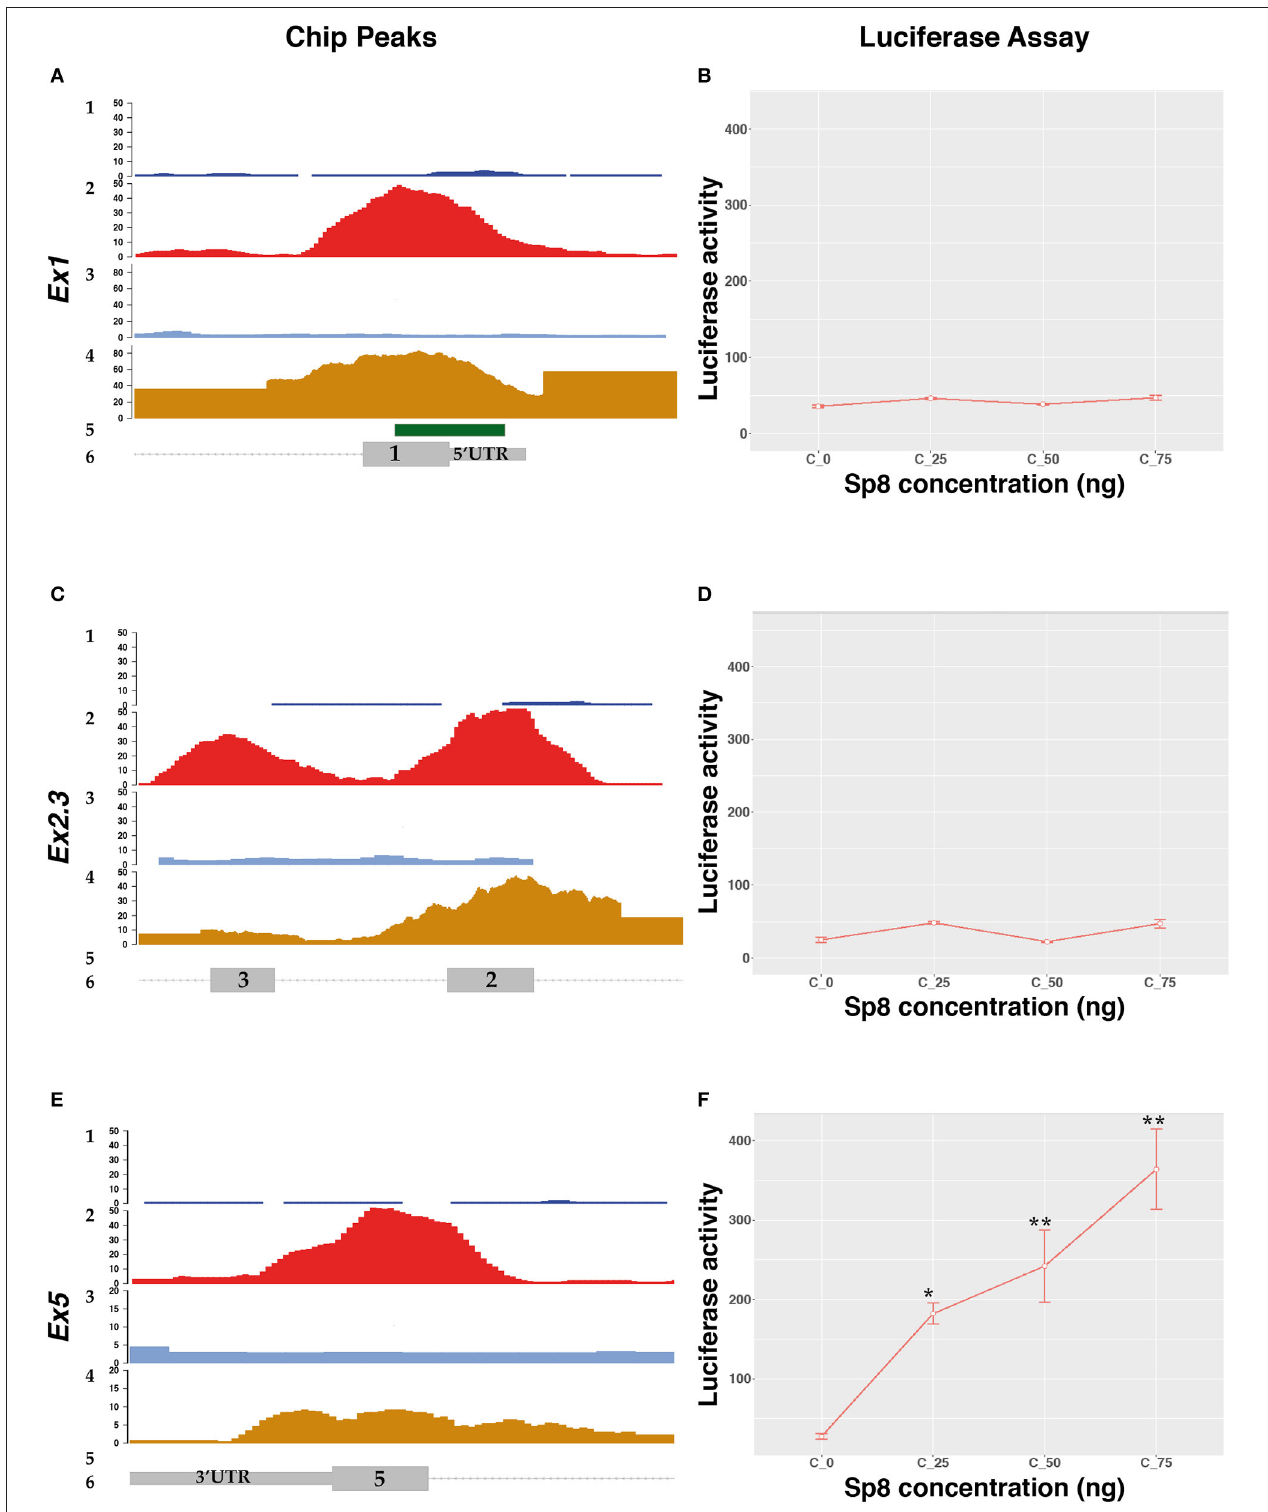
FIGURE 3 | SP8 transcriptional regulation of Ccnd1 genomic regions bound by Sp8. Panels (A,C,E) show details of the Ccnd1 locus where the SP8 ChipSeq peak have been detected: (A) SP8 peak at the Ccnd1 Ex1 fragment; (C) SP8 peak at the Ccnd1 Ex5 fragment; (E) Sp8 peak at the Ccnd1 Ex2.3 fragment. 1: SP8